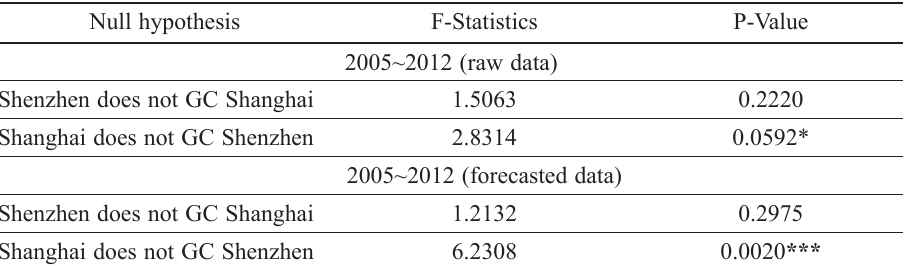
Table 4. Granger causality